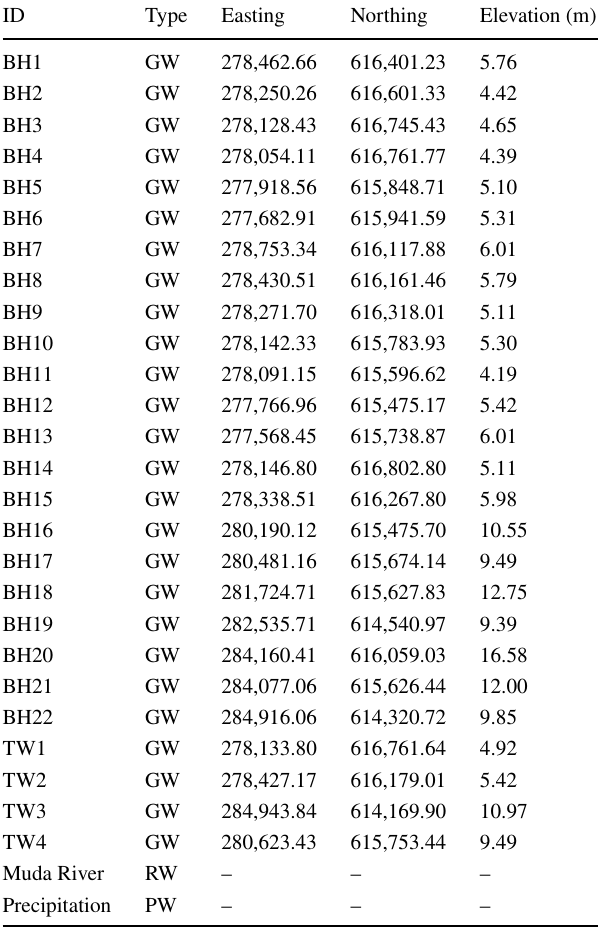
Table 1 Sampling 24 locations including surface water and ground- water of the study area